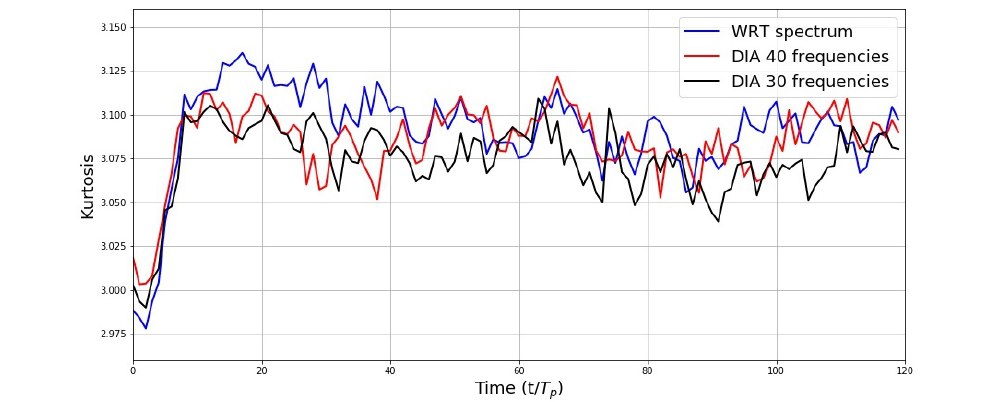
Figure 5. Same as Figure 4 with the use of the weak energy